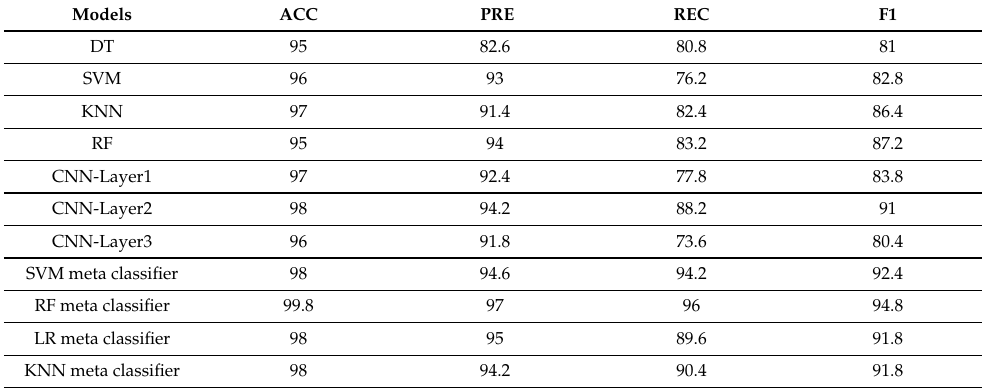
Table 5. The average of ACC, PRC, REC, and F1 when applying the models to the MIT-BIH dataset.